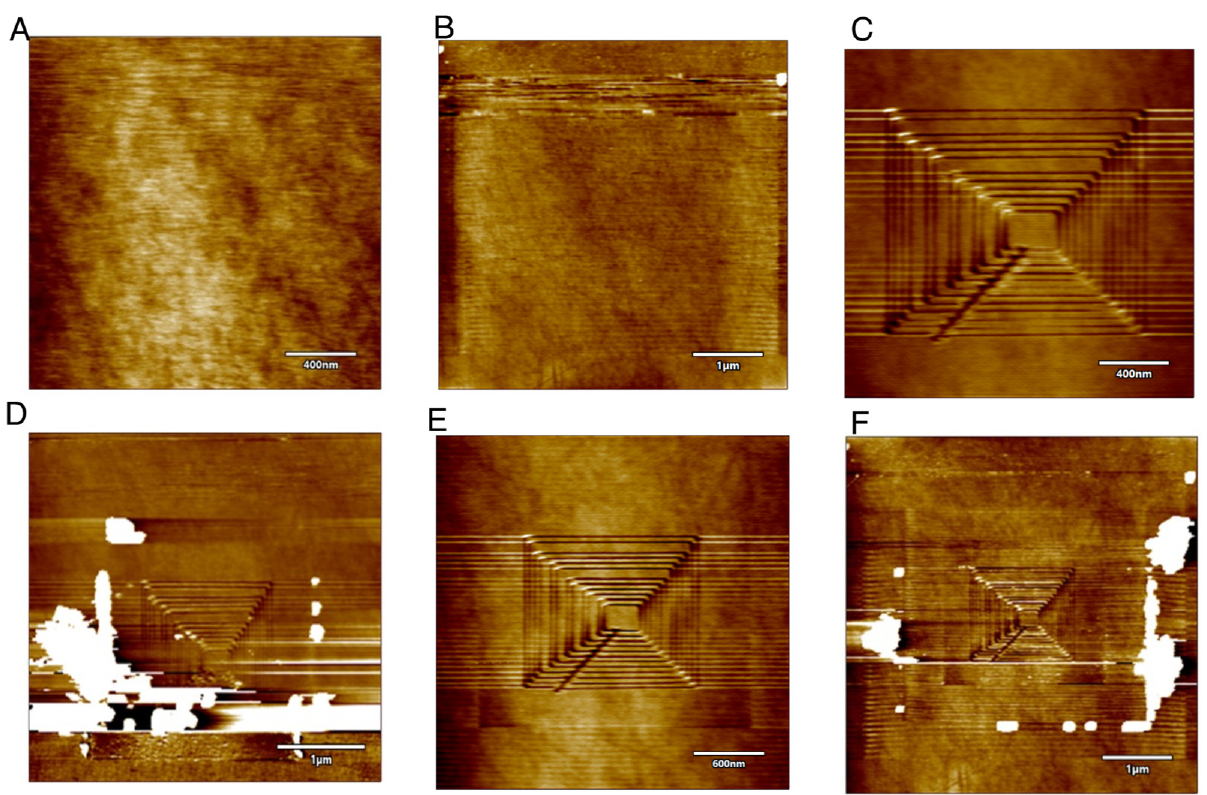
Figure A2. Scratching tests to show the material removal over the silicon substrate. ( A ) Contact mode scanning over 2 × 2 μ m area with a F T of 2 μ N ( B ) Tapping mode scanning of 5 × 5 μ m area ( C ) The concentric circles scratched over the silicon surface with a normal F T of 4 μ N ( D ) The accu- mulation of debris at the boundary of 2 × 2 μ m area ( E ) Contact mode scanning over 3 × 3 μ m area, where the debris accumulated at the 2 × 2 μ m area is swept away ( F ) The displaced debris accumu- lation at the 3 × 3 μ m area boundary, proving the actual materials formed which can be swept away using contact mode scanning, by the AFM tip. Tip bias: 0 V.